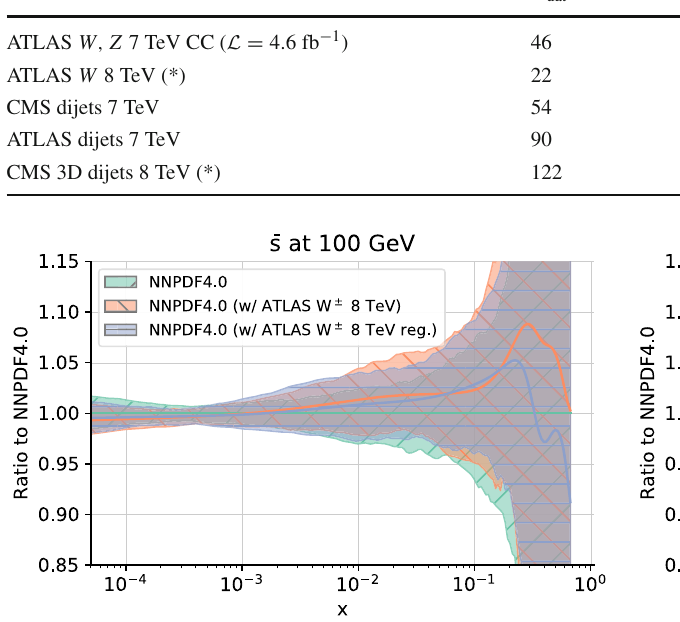
Fig. 57 Comparison to the baseline of PDFs obtained by regularizing the covariance matrix for the ATLAS W 8 TeV (left) and ATLAS 7 TeV dijet dataset (right). In each case, the PDF which is most affected